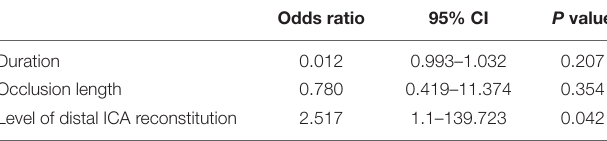
TABLE 5 | Factors affecting recanalization (multivariate